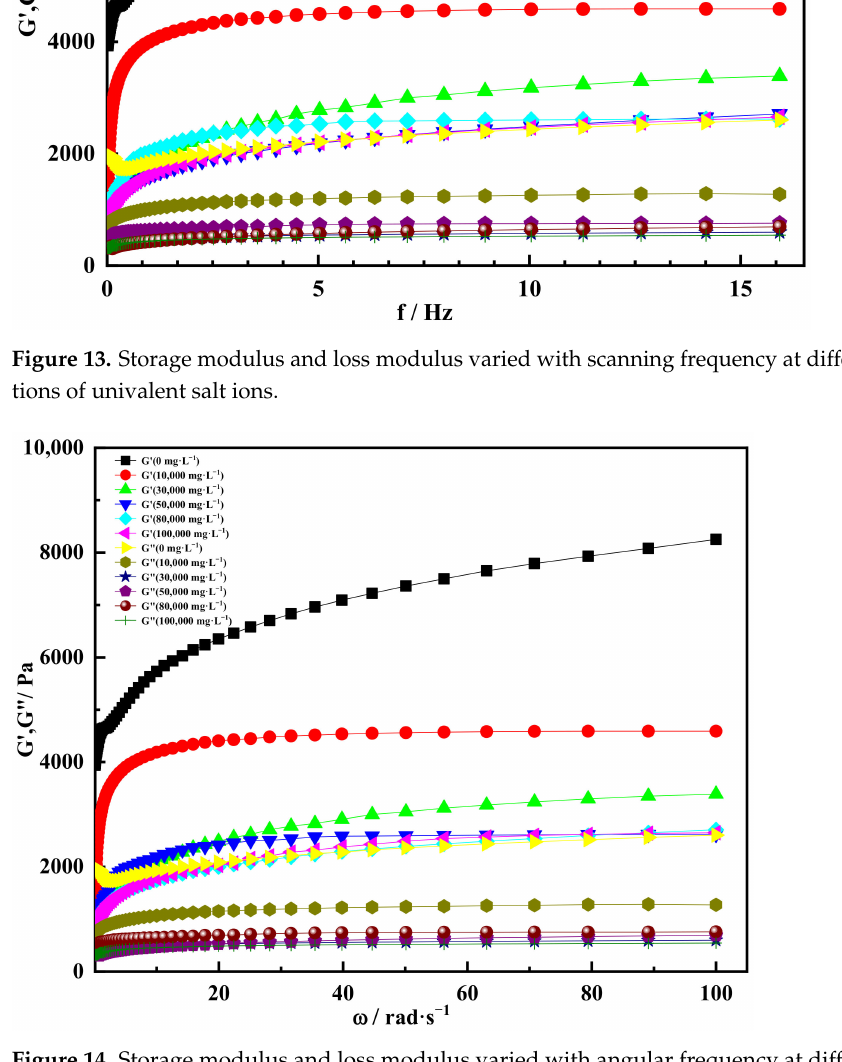
Figure 14. Storage modulus and loss modulus varied with angular frequency at different univalent salt ion